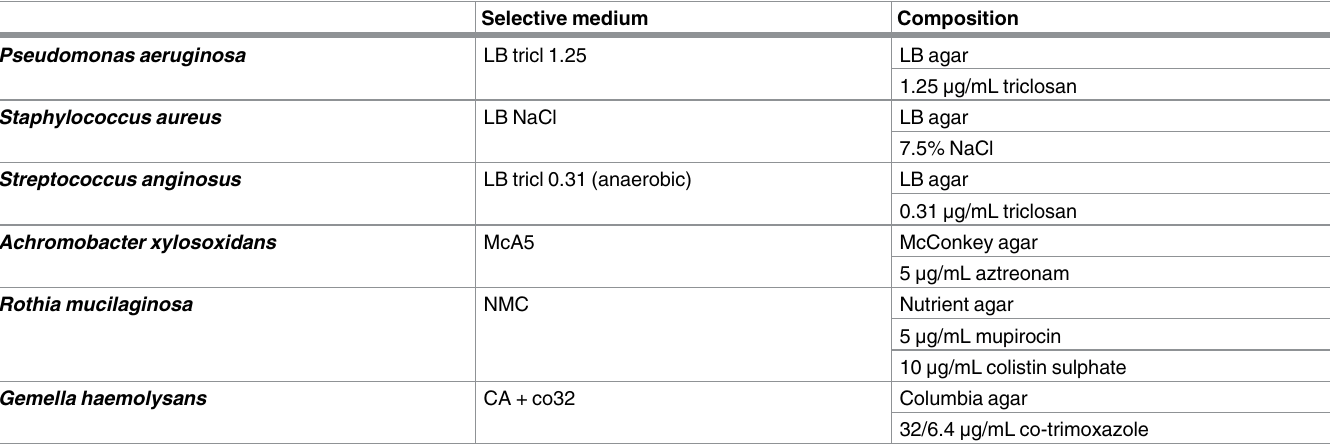
Table 3. Composition of optimized selective